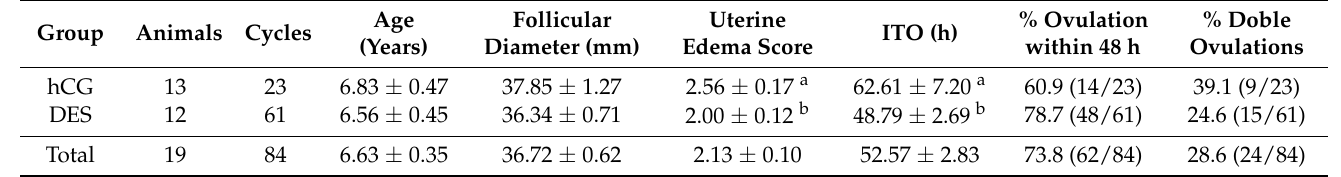
Table 5. Jenny age, follicular diameter and uterine edema score at time of treatment (0–4), interval to ovulation (ITO), percentage of jennies ovulating within 48 h and percentage of double ovulations after the administration of human chorionic gonadotropin (hCG) and deslorelin acetate (DES).